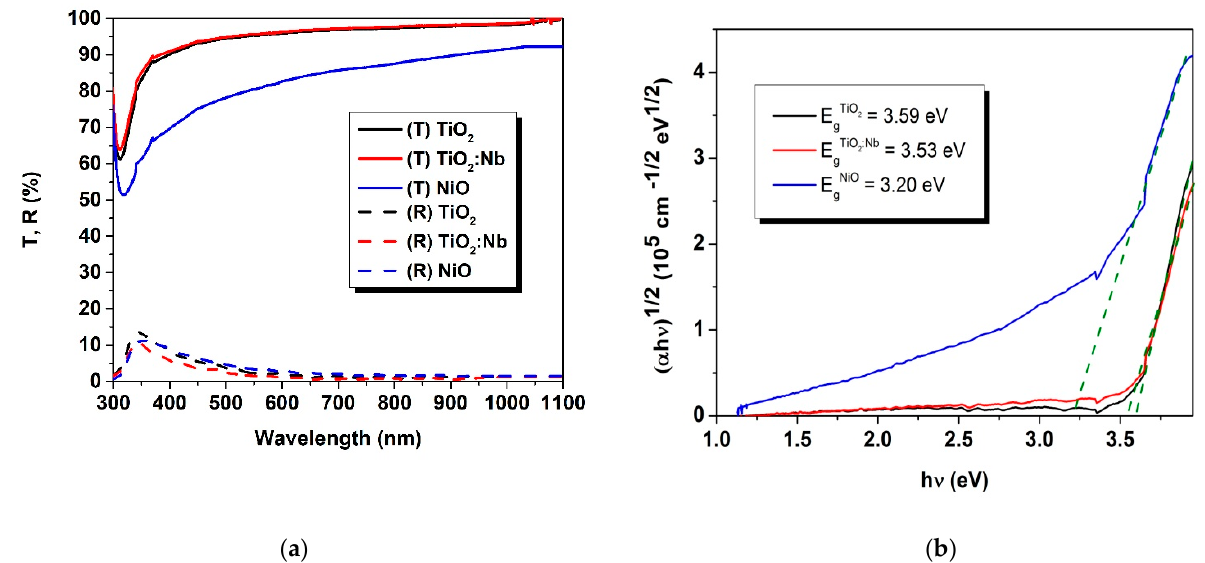
Figure 7 . ( a ) Transmittance and reflectance spectra for the single-layer coatings; ( b ) energy band gap calculation using spectrophotometry data. Table 4. Energy band gap values from spectrophotometric and ellipsometric measurements.